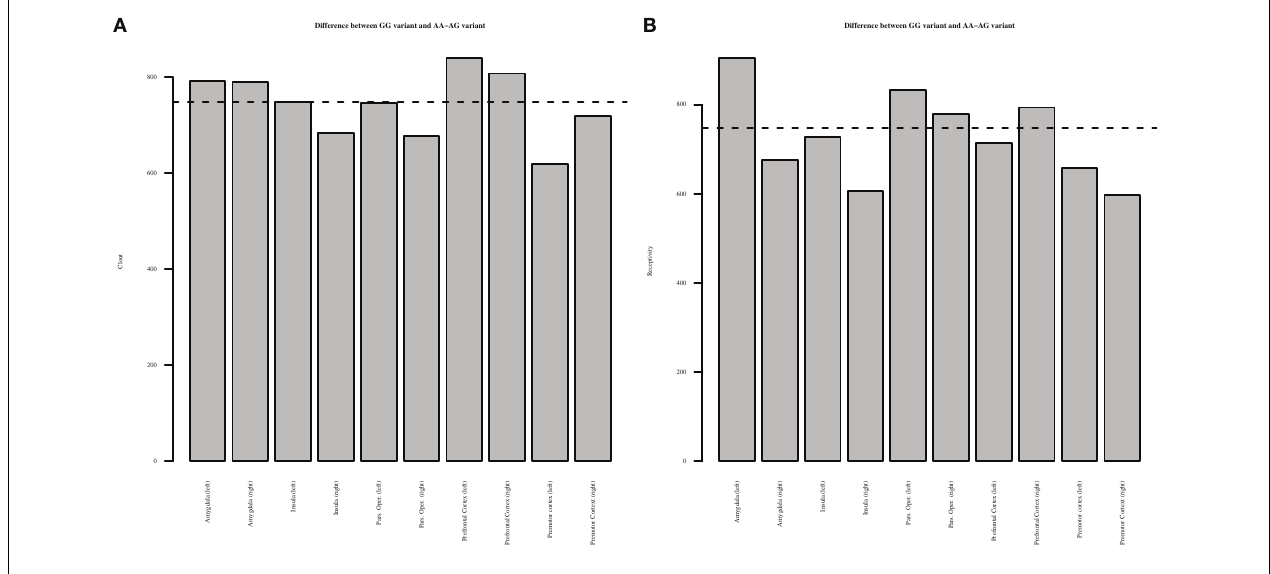
FIGURE 2 | El-Himdi Roy Test—Differences between OXTR GG and AA-AG allele groups. This figure reports the test statistic that assesses whether the clout (panel A ) or receptivity (panel B ) of a focal brain region in the GG allele group minus the clout or receptivity of a focal